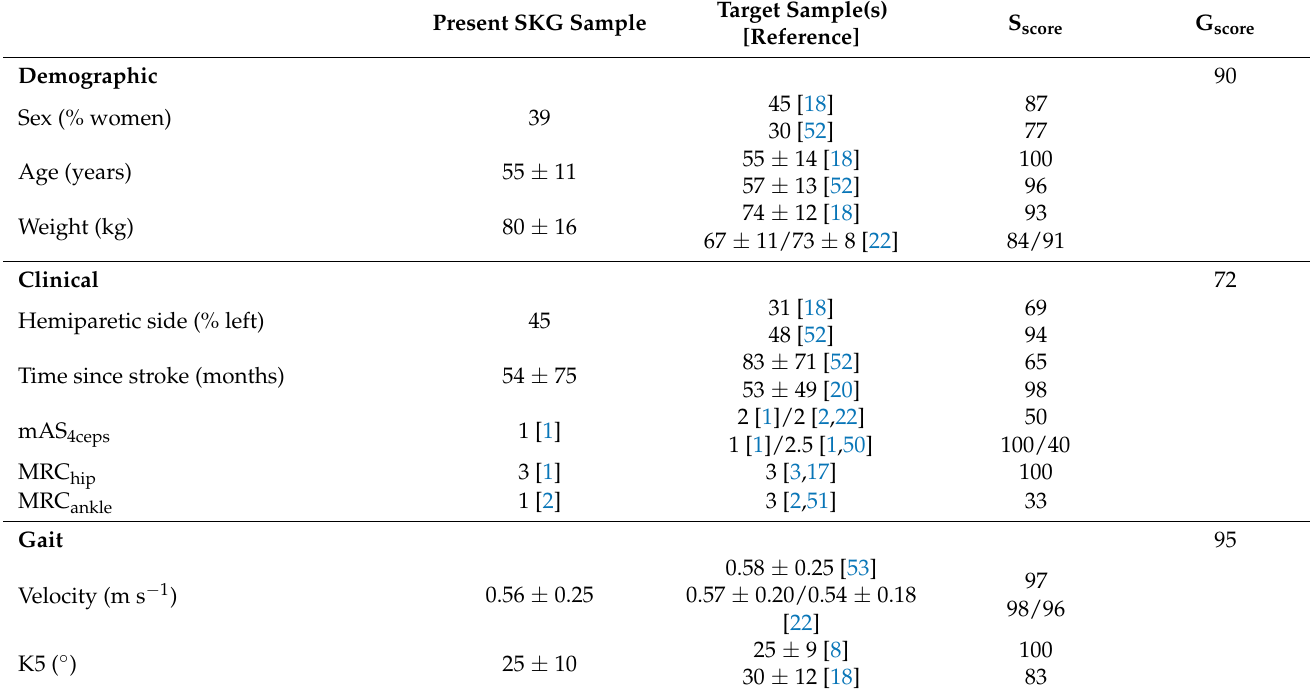
Table 5. Comparison between the present SKG sample and other target samples from the literature using S scores and G scores . Values are expressed in numbers, mean ± SD, or median and [interquartile range] for samples and in percent for S scores and G scores . Target Sample(s) S score G score Present SKG Sample [Reference] 90